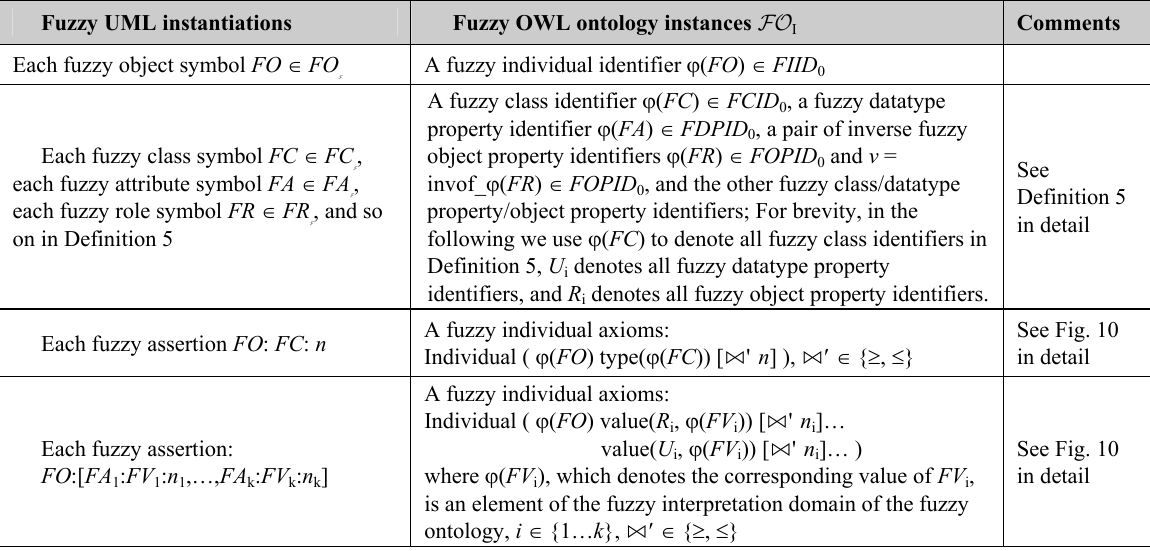
Table 3. Transforming rules from the fuzzy UML instantiations to the fuzzy OWL ontology instances. Fuzzy UML instantiations Fuzzy OWL ontology instances FO